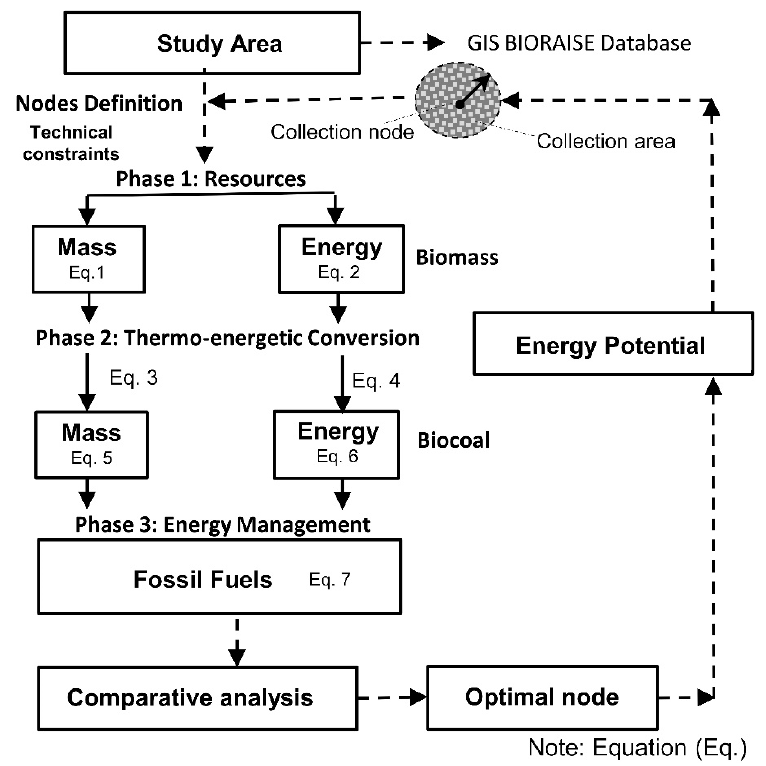
Figure 2. Flowchart of the multiphase mathematical algorithm through mass and energy balance.